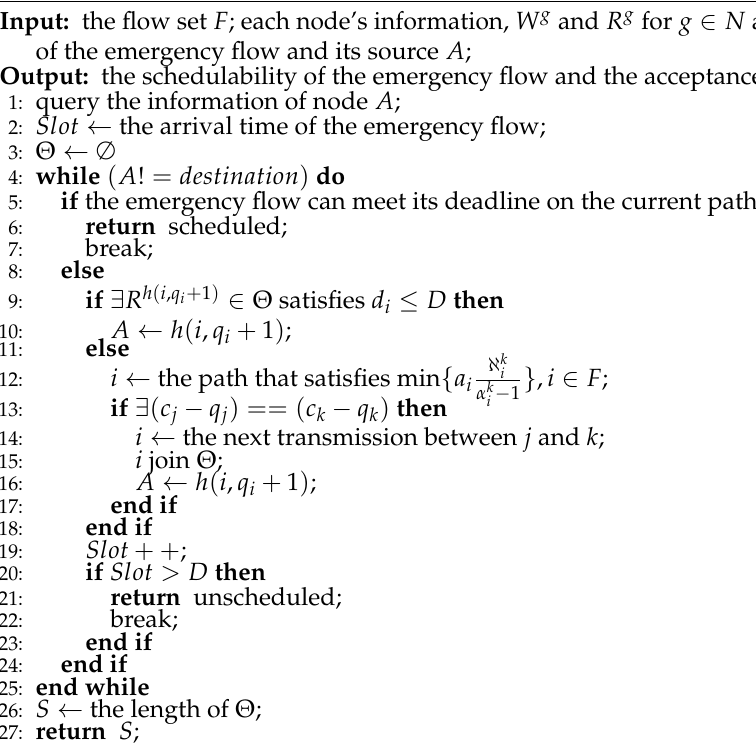
Algorithm 5 Optimal benefit-based stealing scheduling